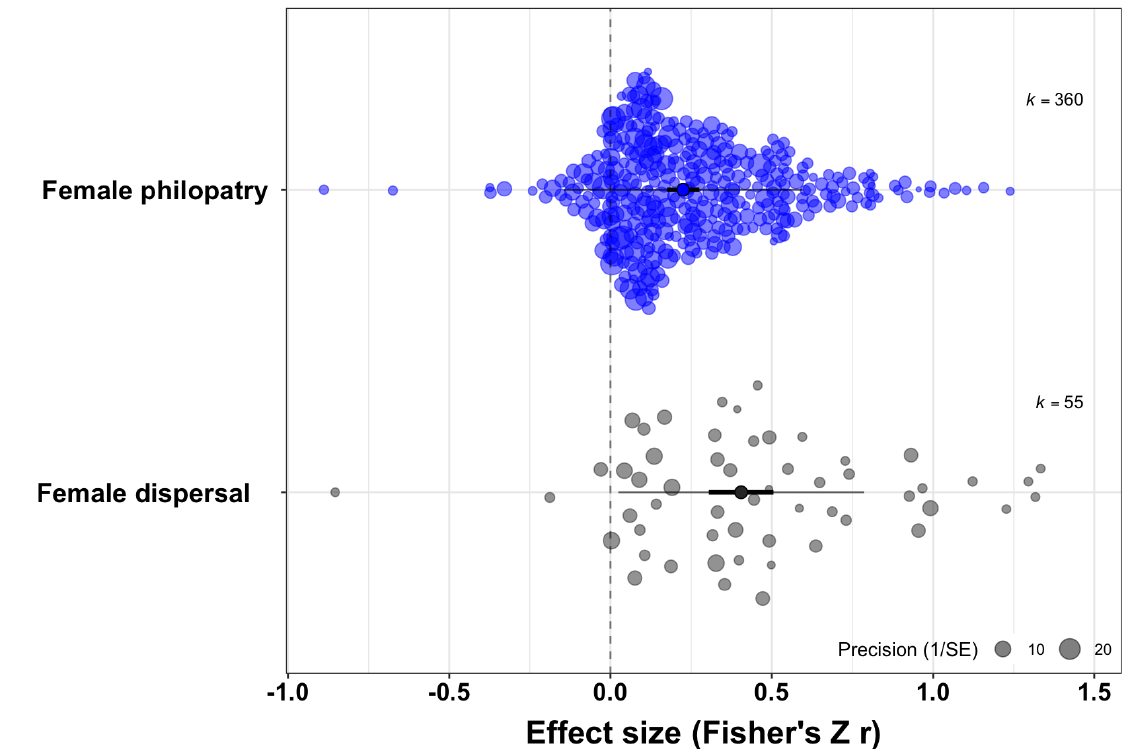
Figure 8 . Effect sizes of dominance rank on female reproductive success are lower in species in which females are philopatric and remain in the group/area where they have been born (top, blue dots) than in species in which females disperse to breed (bottom, grey